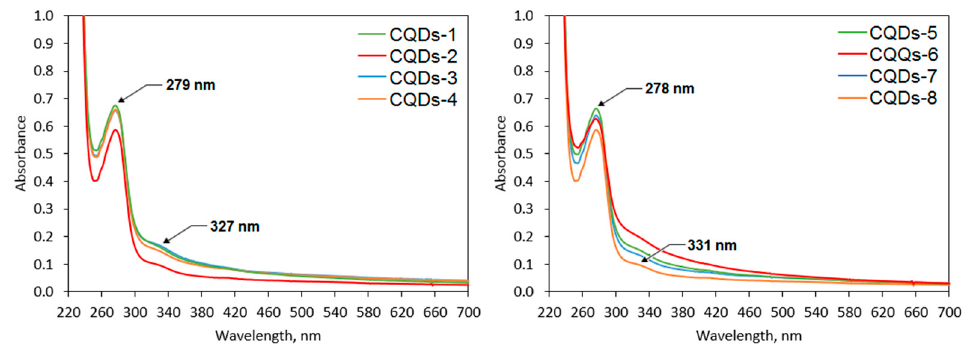
Figure 7. UV–Vis spectra of the coumarin-modified CQDs .